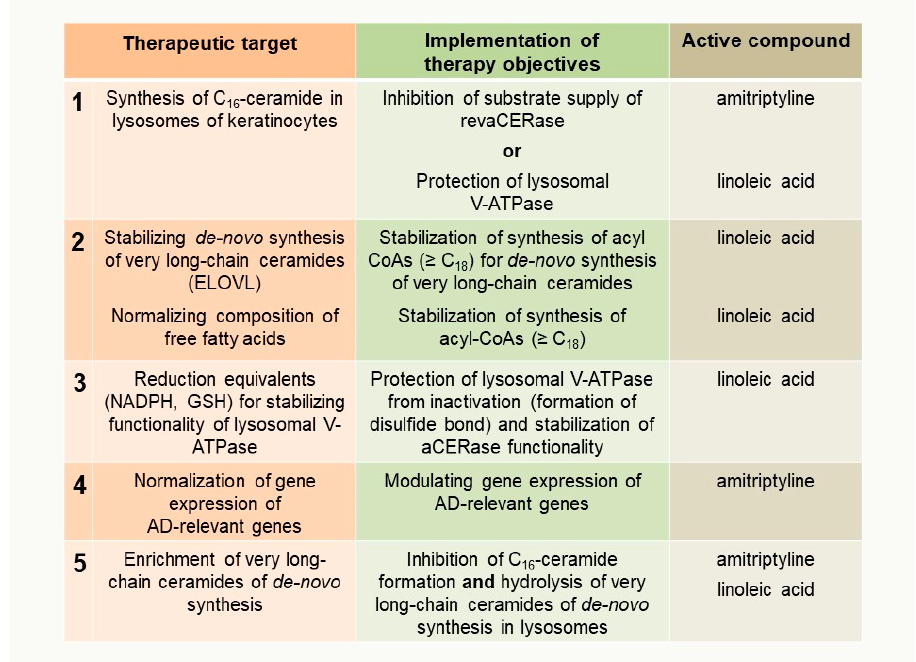
Figure 7. Derived therapeutic targets and the implementation of therapy objectives to reduce keratinocytes with disturbed maturation and premature apoptosis in the stratum corneum of AD patients. Therapeutic targets are listed in chronological order in sections 5 and 6.